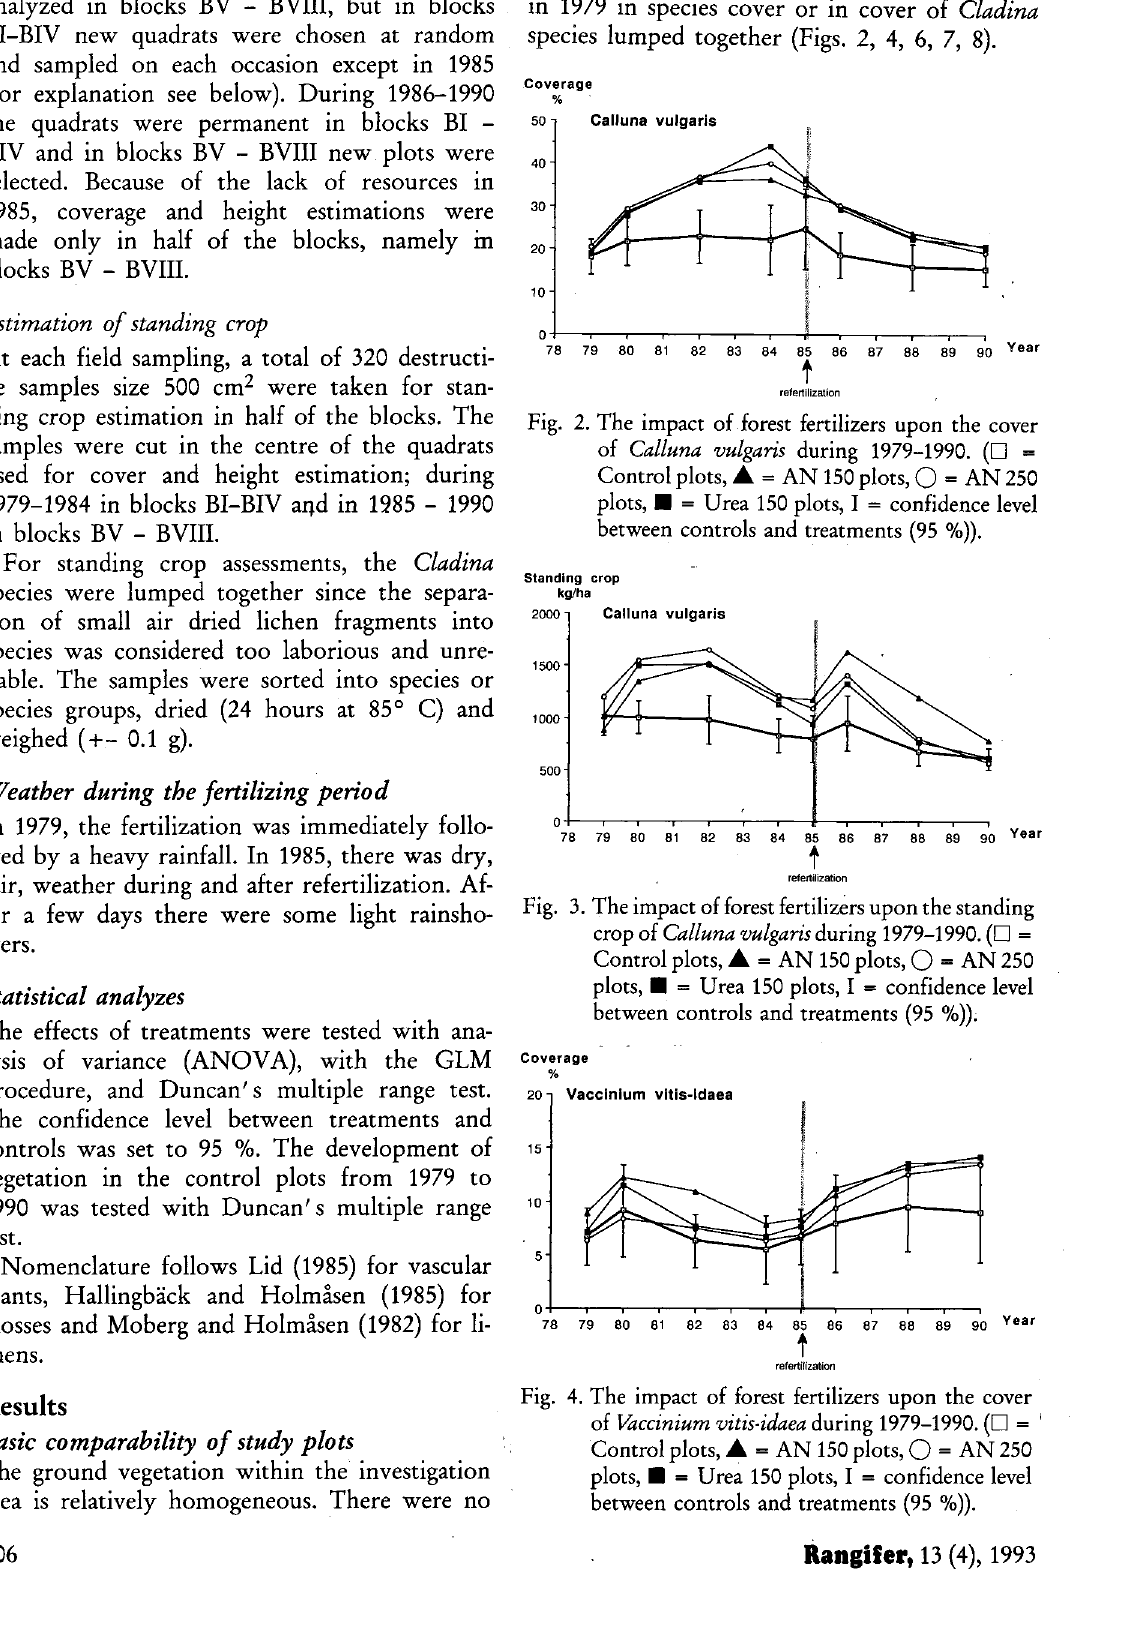
Fig. 2. The impact of forest fertilizers upon the cover of Calluna vulgaris during 1979-1990. (• = Control plots, A = AN 150 plots, O = AN 250 plots, • = Urea 150 plots, I = confidence level between controls and treatments (95 %)).